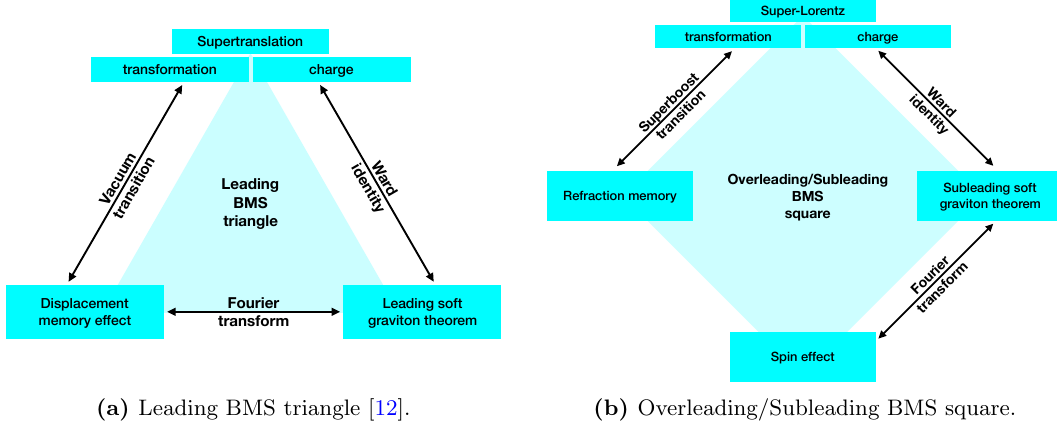
Figure 2. The infrared structure of asymptotically (cid:13)at spacetimes at null